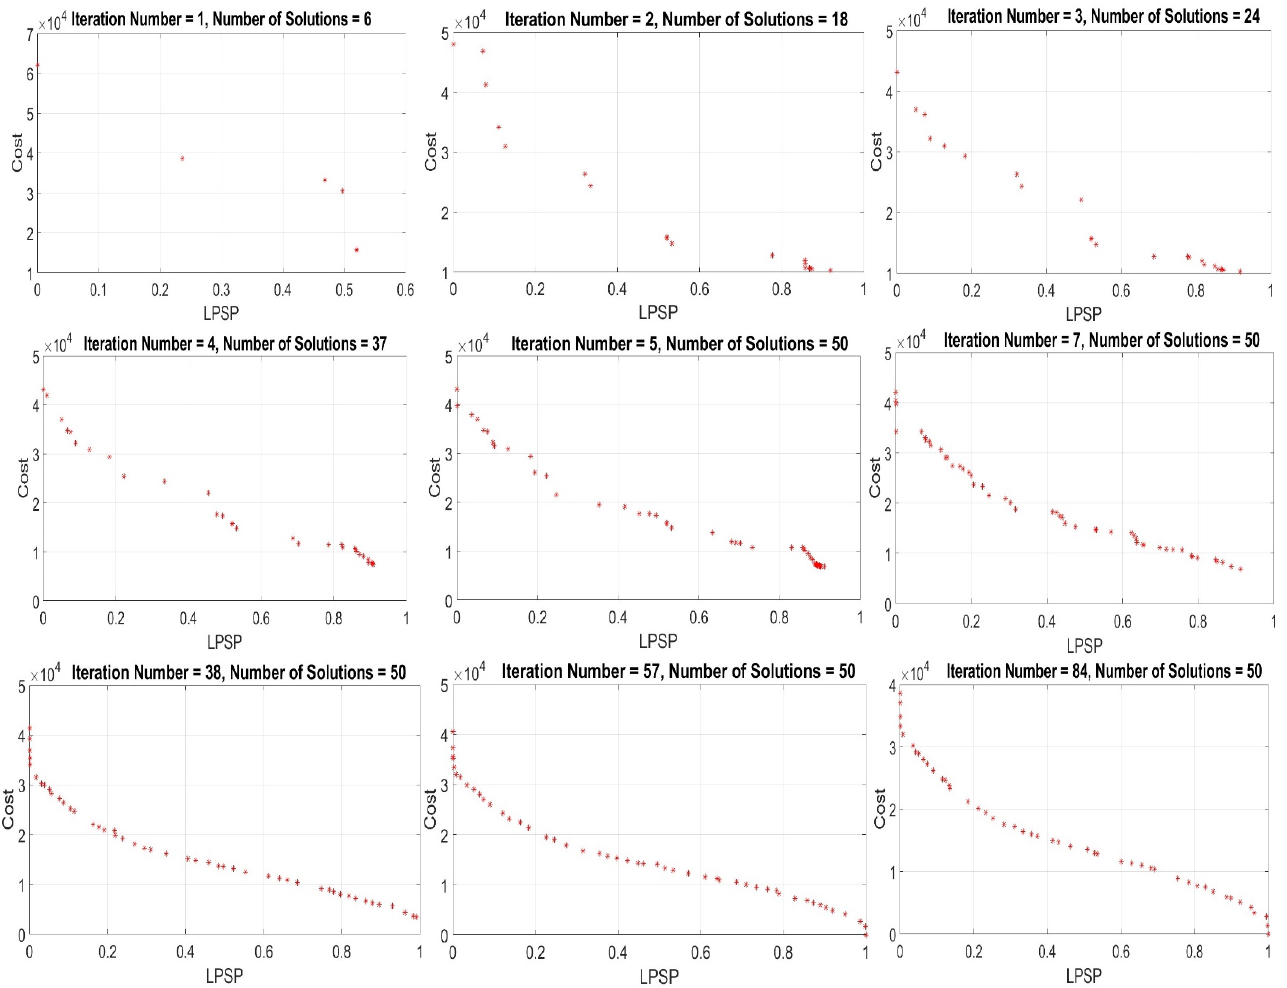
Figure 5. Gradual convergence of the solutions in the NSGA-GWO